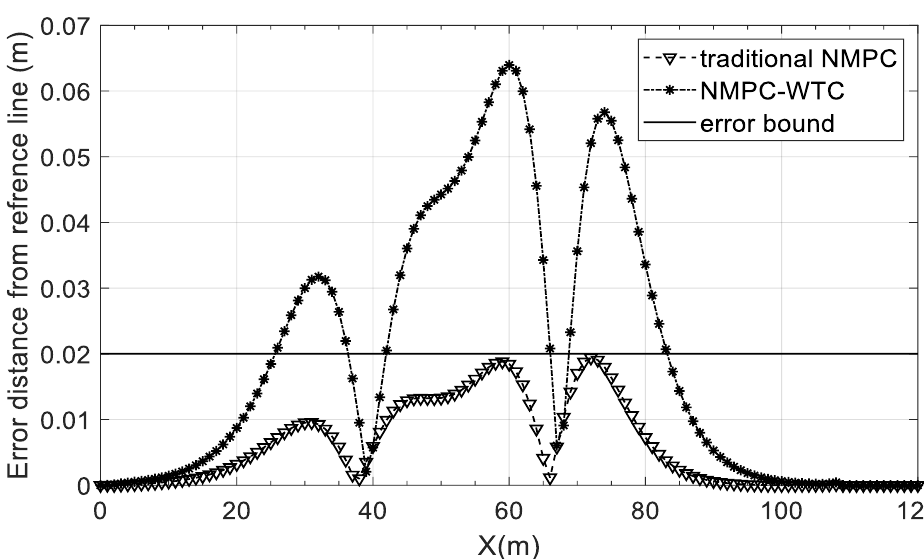
Figure 5. Path tracking in double line shifting scenario.